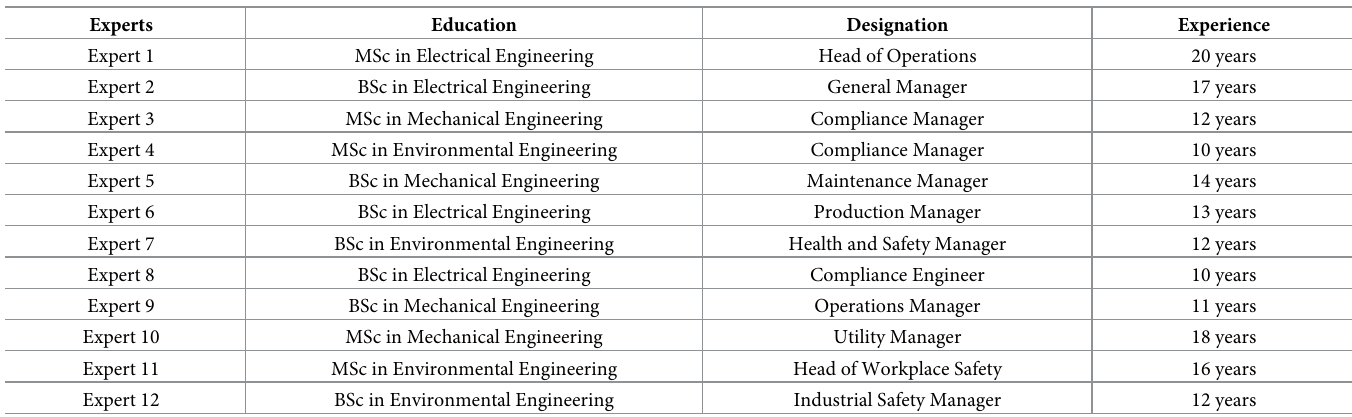
Table 2. Profile of the